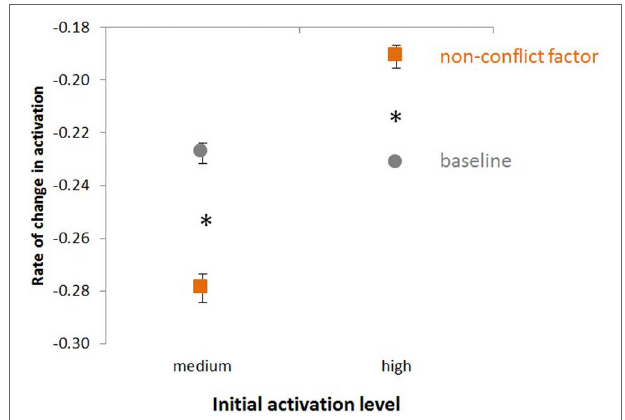
FIGURE 4 | Intentions with high activation avoid conflict with other high-active intentions . A priori contrasts indicate significant differences ( p < 0.05) between means, as shown by asterisks. The main effects of activation level and type of agent are significantly different ( p < 0.05) in a 2 (cid:2) 3 ANOVA, with a low activation level condition included but not shown for clarity and